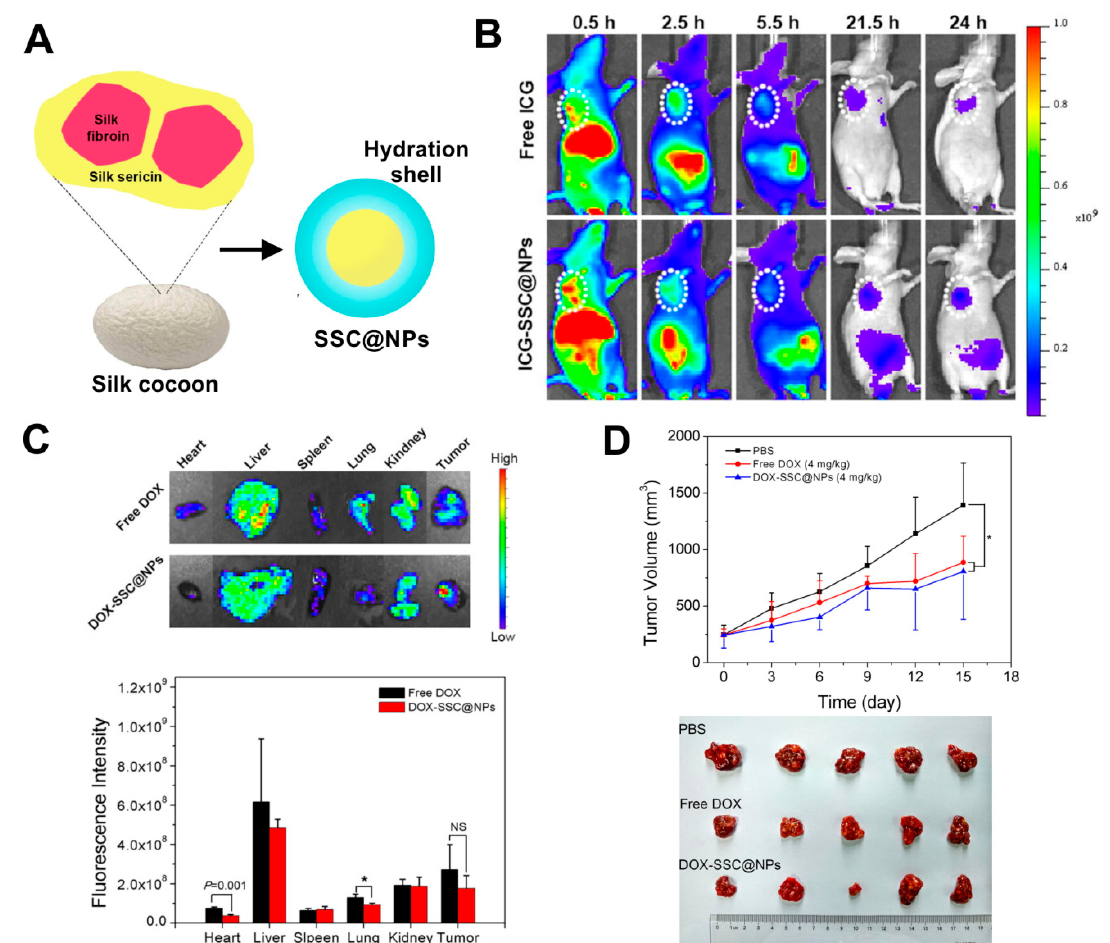
Figure 3. Hydrophilic silk sericin-based nanoparticles (SSC@NPs) in the treatment of cancer. ( A ) Schematic illustration of SSC@NPs. ( B ) The fluorescence imaging of mice bearing MCF-7 tumors at 24 h after intravenous administration of free dye indocyanine green ICG or ICG-SSC@NPs. The tumors are pointed with white circles. ( C ) Top: ex vivo images of major organs and tumors resected from HepG2-bearing mice after 24 h of treatment with free Dox and Dox-loaded DOX-SSC@NPs (NPs contained 2.5 mg/kg of Dox); Bottom: the graph demonstrating Dox distribution in major organs and tumors analyzed at 24 h post-injection. ( D ) In vivo therapeutic efficacy Dox-loaded DOX-SSC@NPs in reference to control Phosphate buffered saline PBS and free Dox in HepG2 tumor-bearing animals. Top: The time dependent tumor volumes after treatment. Bottom: Image of resected